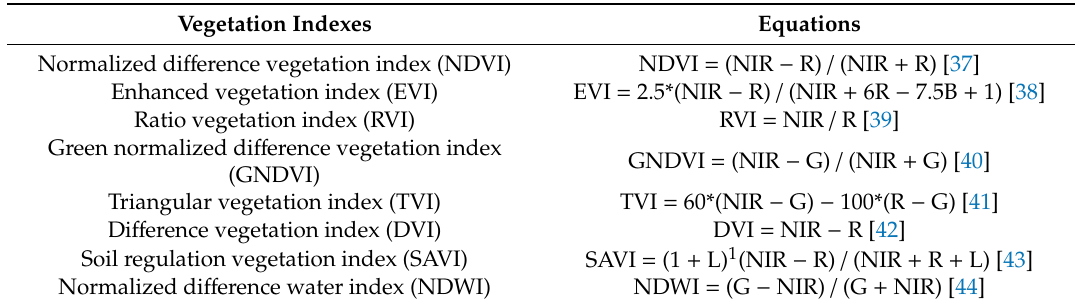
Table 3. Vegetation indexes selected in the study.